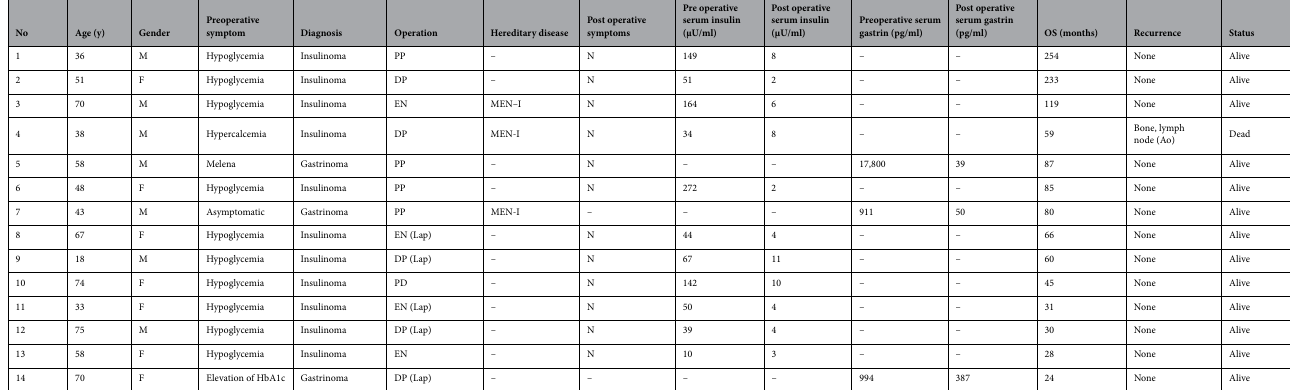
Table 1. Clinical and biochemical characteristics of the study patients (N = 14). Ao aorta, DP distal pancreatectomy, EN enucleation, Lap laparoscopic, MEN-I multiple endocrine neoplasia type 1, N none, OS overall survival, PD pancreaticoduodenectomy, PP partial